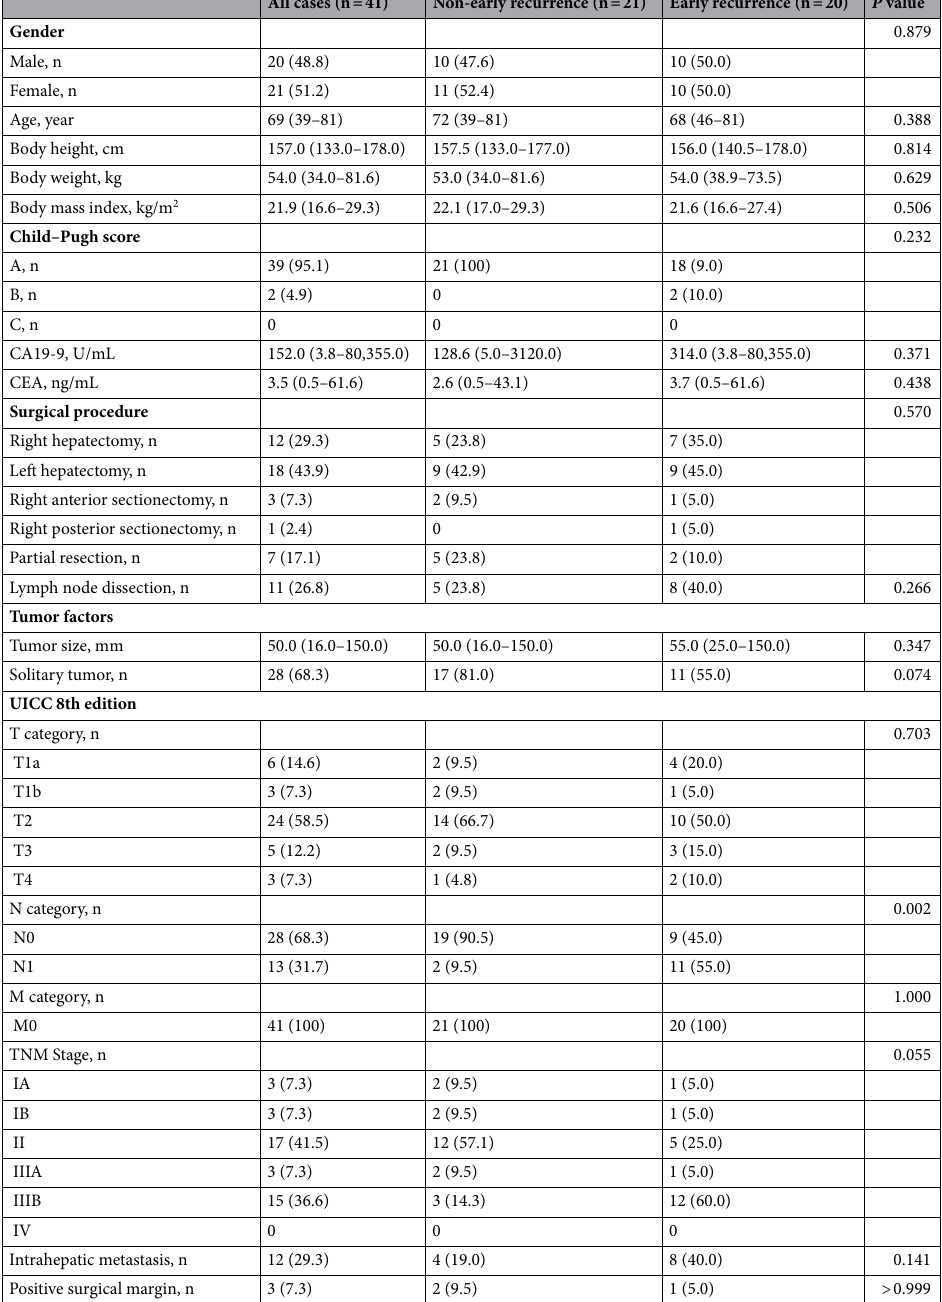
Table 1. Comparison of the perioperative characteristics of the non-early recurrence and early recurrence groups. CA19-9 carbohydrate antigen 19-9, CEA carcinoembryonic antigen, UICC union for international cancer